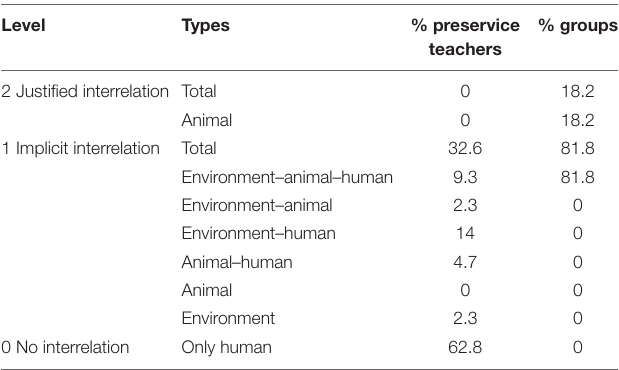
TABLE 1 | Percentage of individual and group proposals in each level of performance in interrelationship-identification among the dimensions of the One Health